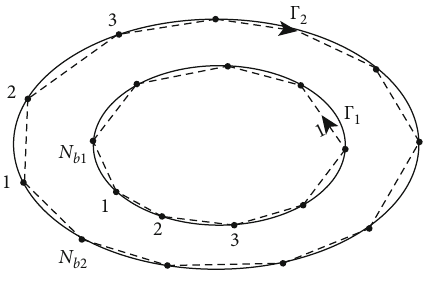
Figure 2: Schematic diagram of circular boundary linearization.